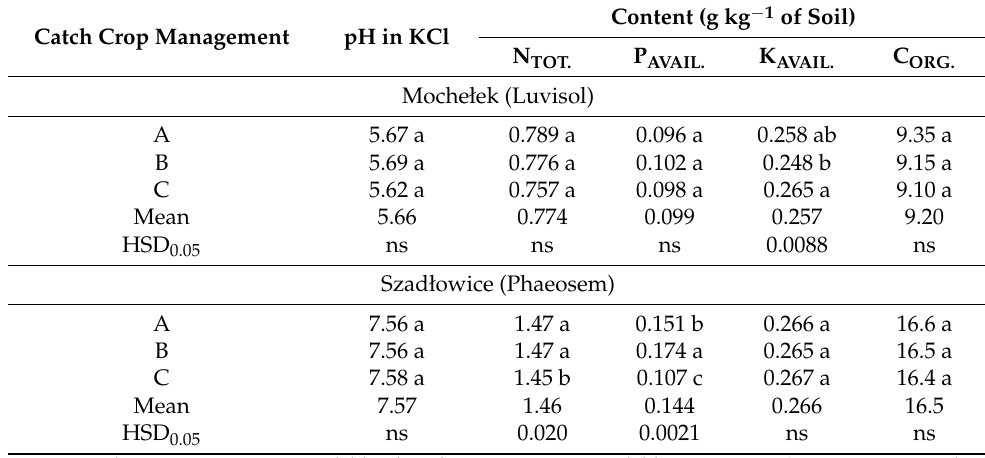
Table 6. Exchangeable acidity and the content of macroelements in soil after spring barley harvesting— means for 2008 to 2010. Catch Crop Management pH in